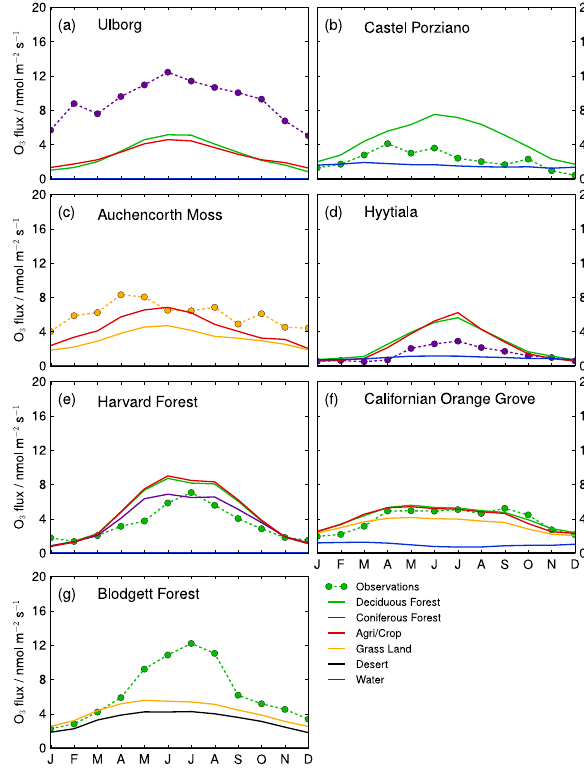
Figure 8. Measured and modelled monthly average O 3 dry de- position fluxes at Ulborg (a) , Castel Porziano (b) , Auchencorth Moss (c) , Hyytiala (d) , Harvard Forest (e) , Californian citrus or- chard (f) , and Blodgett Forest (g) . Grey lines show results from individual models and blue lines show observations for different years.